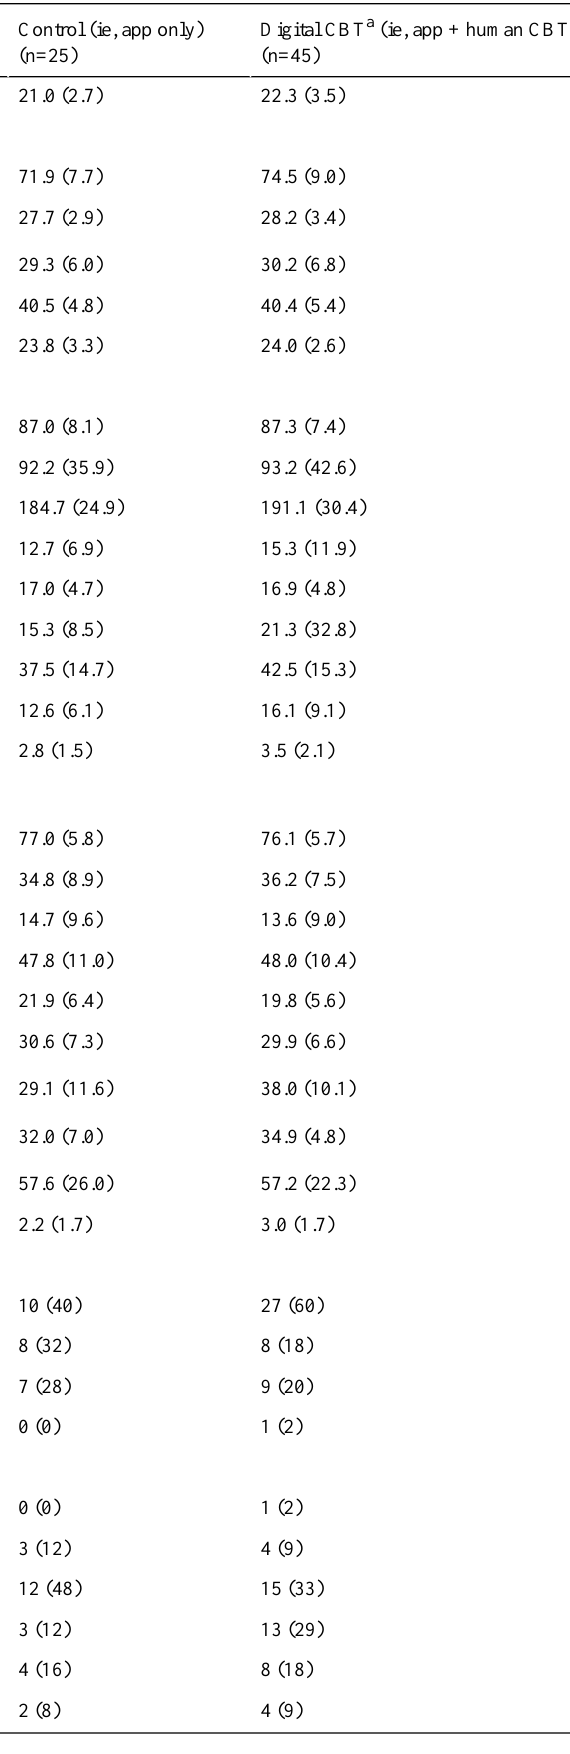
Table 1. Baseline characteristics of participants in both